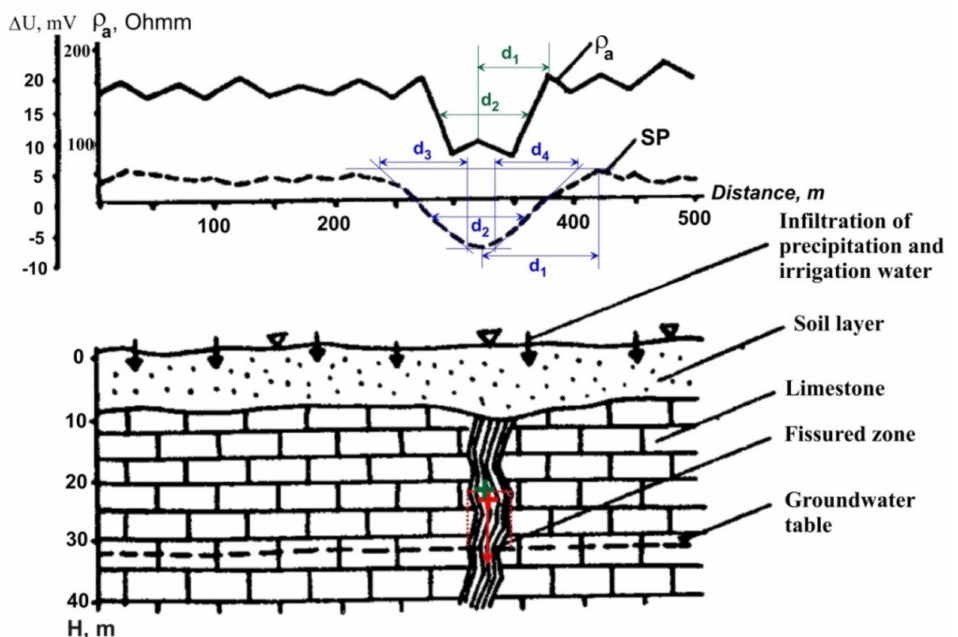
Figure 20. The interpretation of SP anomaly over the fissured zone (Russia) (resistivity and SP graphs and geological section are from [105]). The red and green crosses show the positions of the upper edge of the anomalous target determined from SP and resistivity curves, respectively. The red arrow indicates the orientation of self-potential